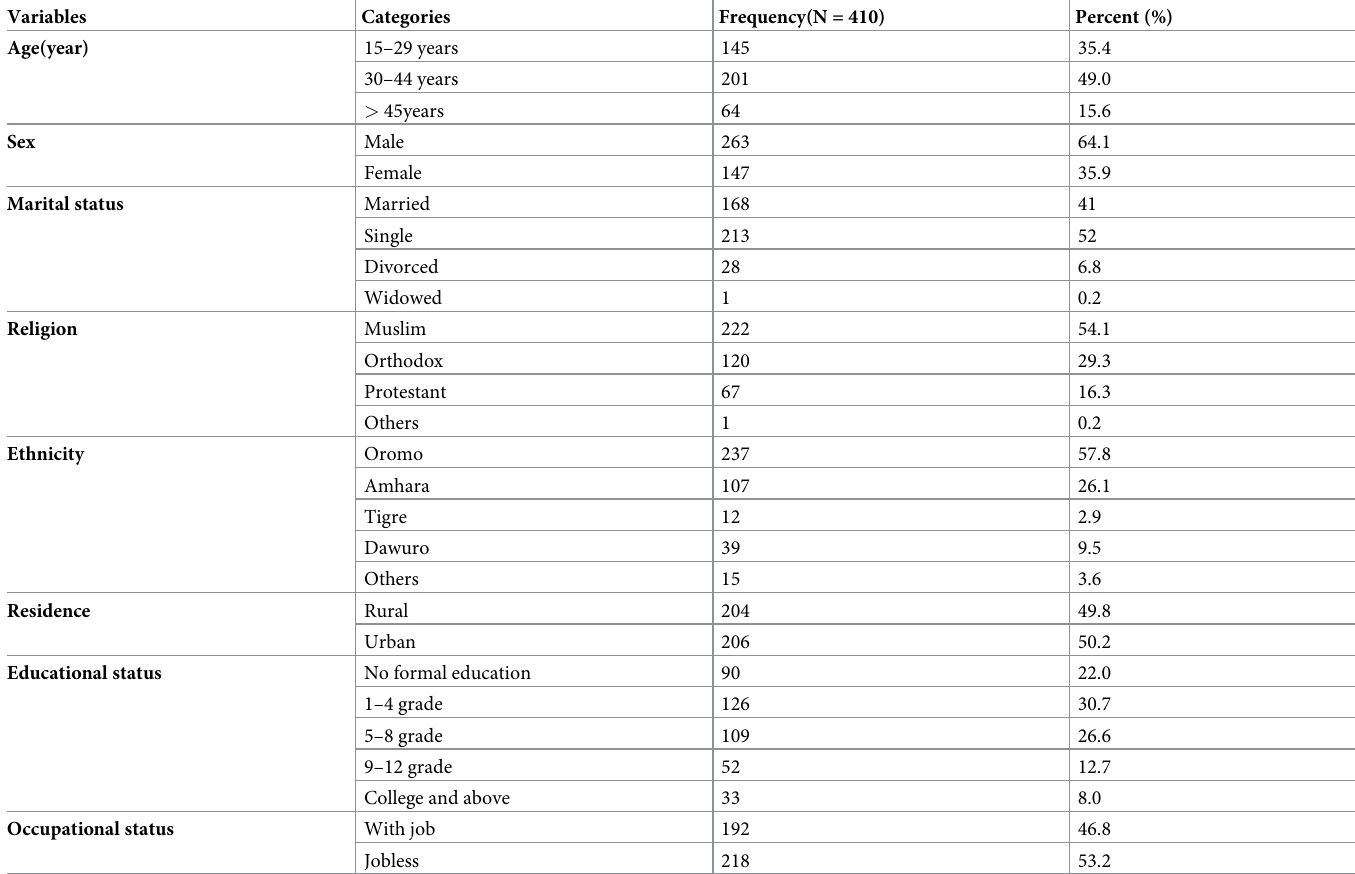
Table 1. Socio-demographic characteristic distributions of mental ill patients attending follow-up treatment at JMC, 2019.